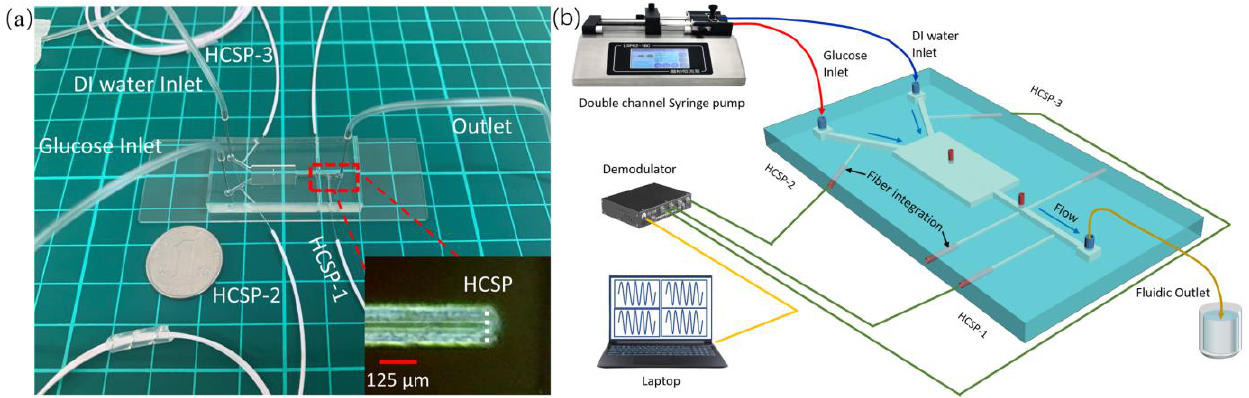
Figure 3. ( a ) View of the microchips connected to liquid pipes and HCSP, the insert is view of HCSP. ( b ) Experimental diagram of HCSP integrated microchips and demodulation